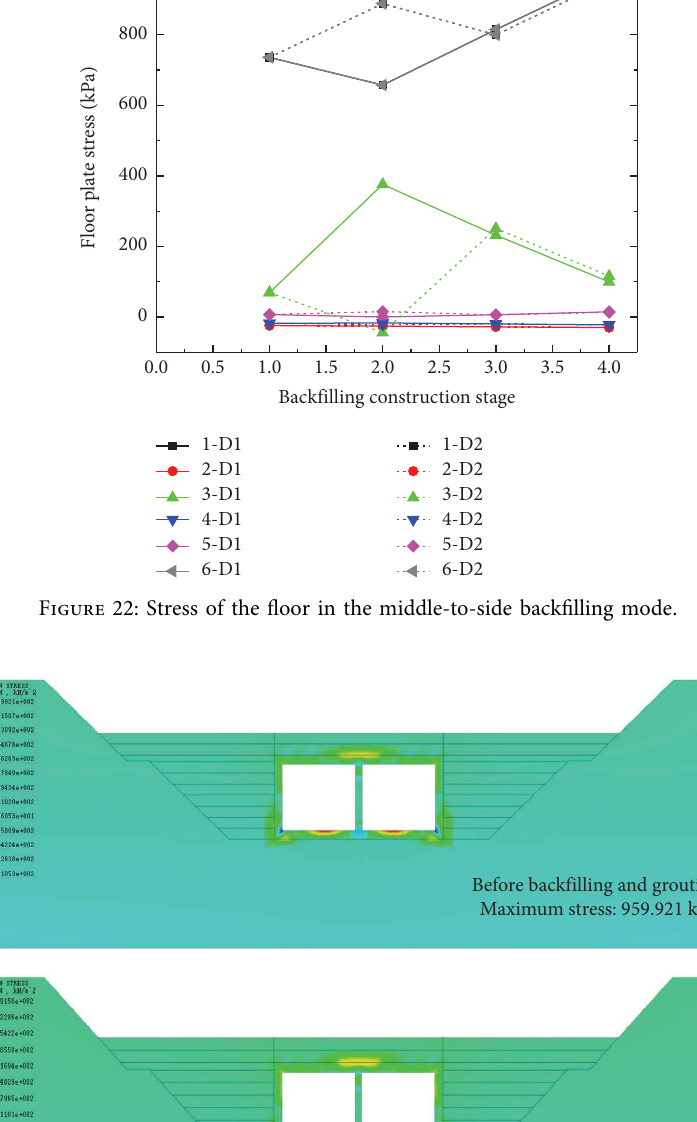
After backfilling and grouting Maximum stress: 999.150 kN